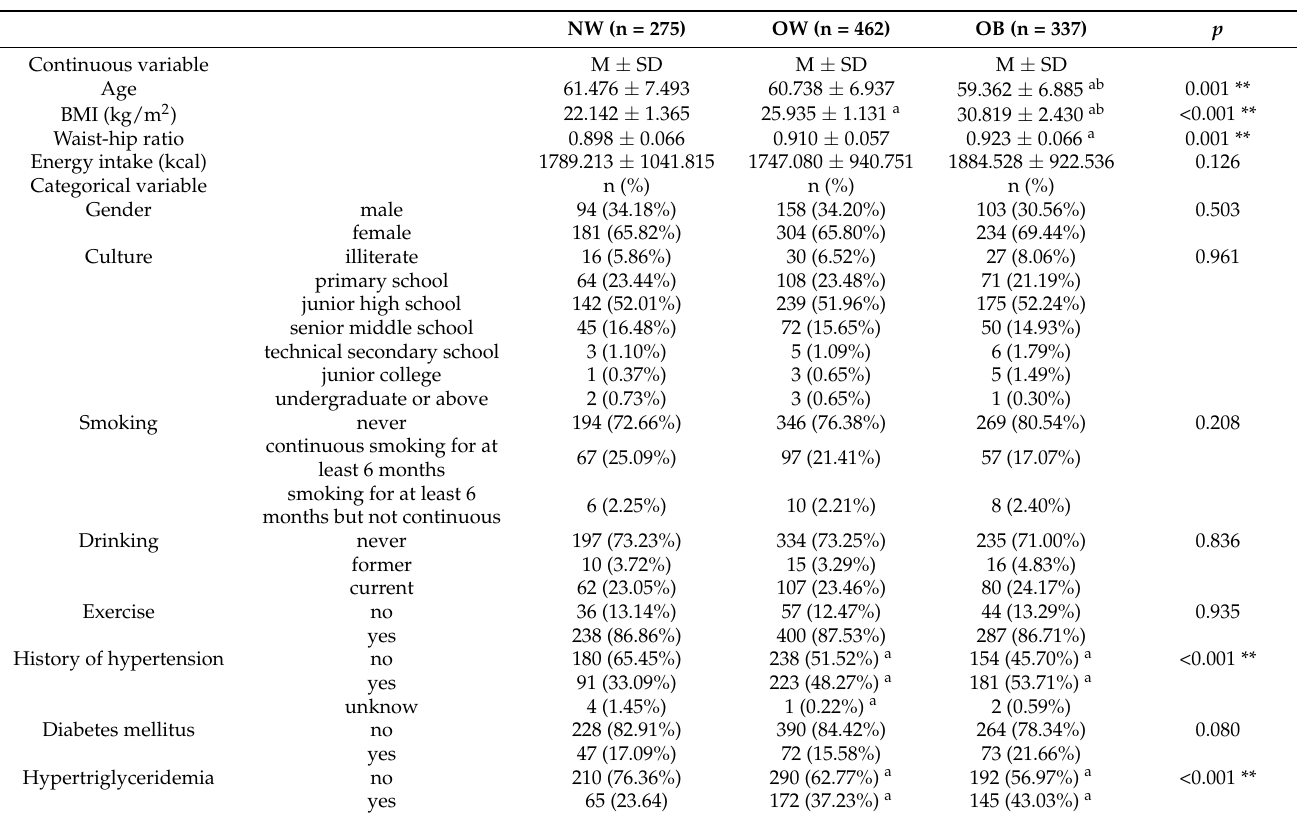
Table 1. Demographics of the study population.